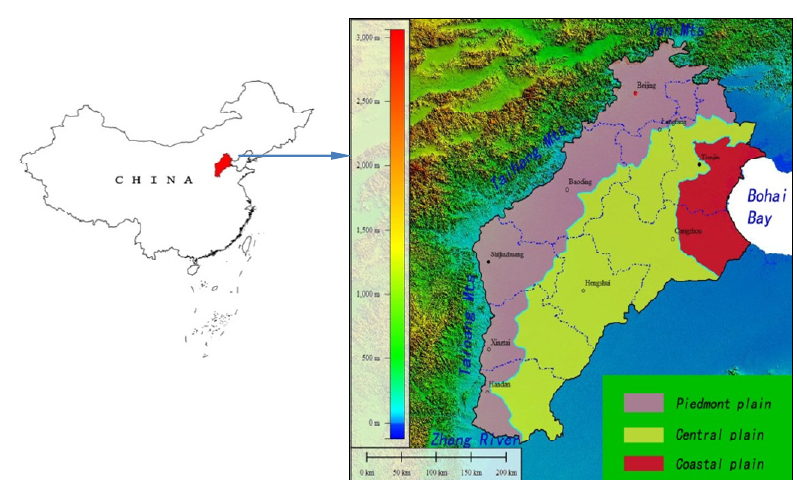
Figure 1. Location and topography of study area